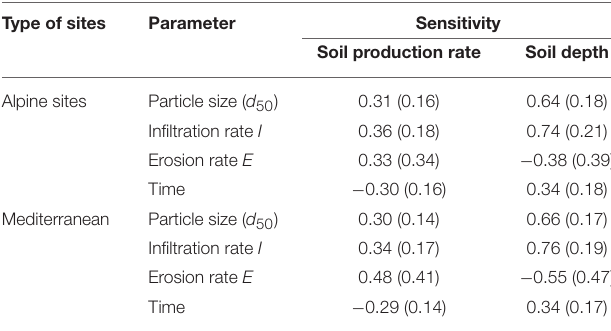
TABLE 1 | Normalized sensitivity coefficients in response to the site type (average and standard